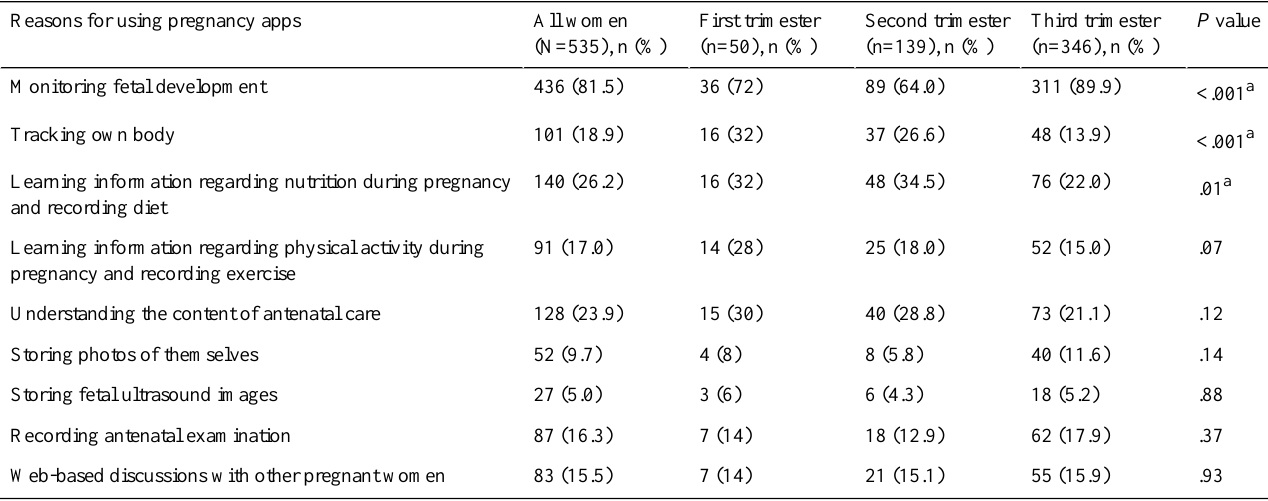
Table 4. Reasons for using pregnancy apps by the trimester of pregnancy.